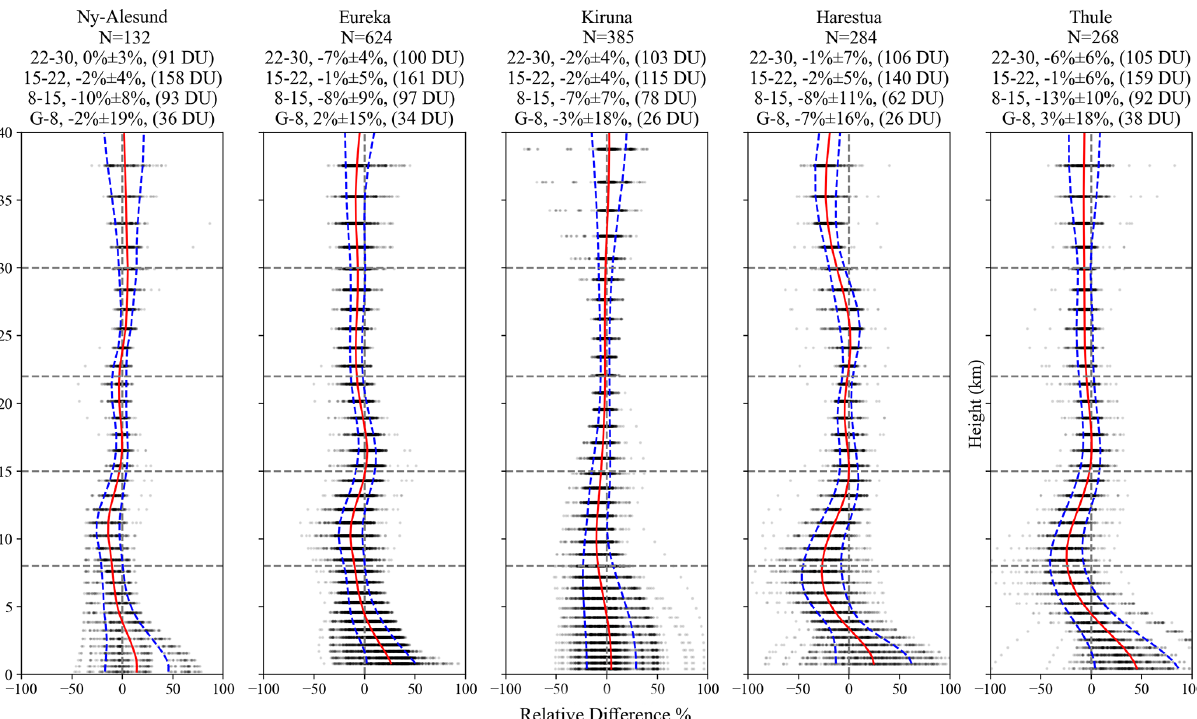
Figure 4. Same as Fig. 3 but for relative differences of FTIR retrieved ozone from MERRA-2. Statistical summaries of the MERRA-2 and NDACC comparisons in four layers (ground to 8, 8–15, 15–22, and 22–30km) for each station are shown above each